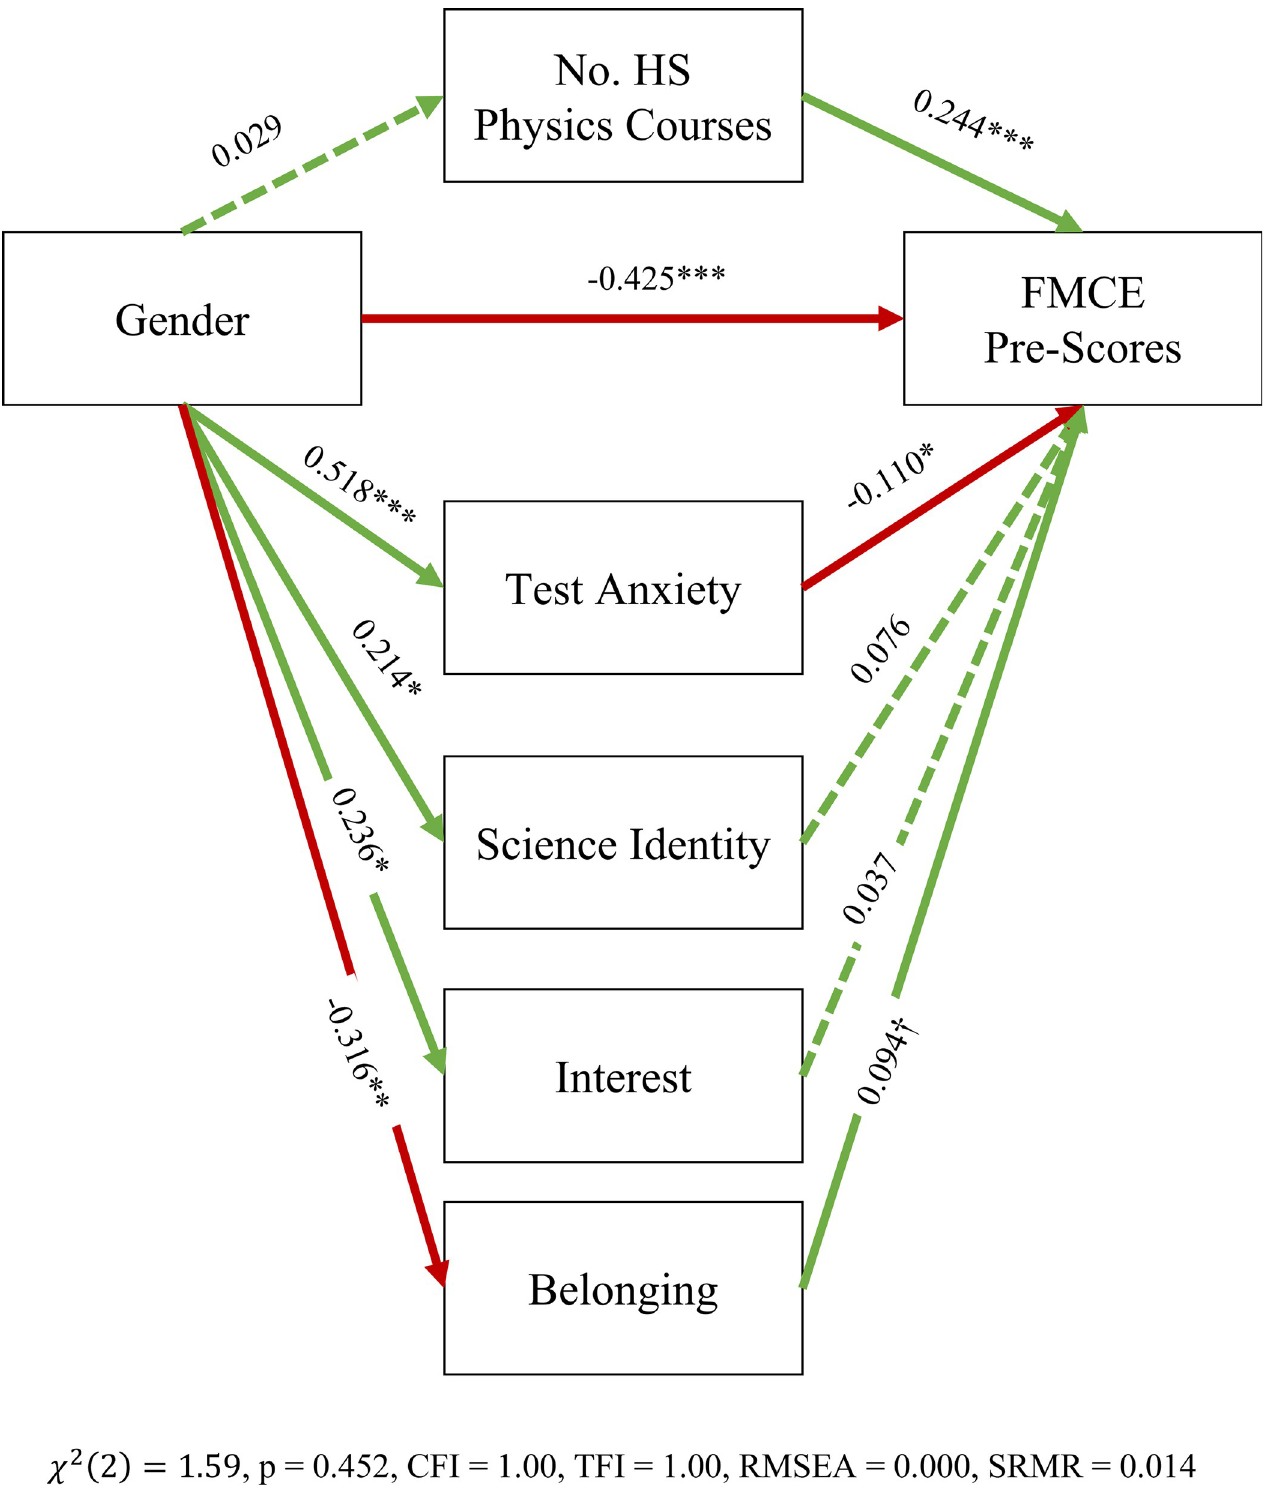
Fig 3. SEM model of the effects of gender on FMCE pre-scores as mediated by number of high school physics courses, test anxiety, science identity, and interest in physics. ��� p < 0.001, �� p < 0.01, � p < 0.05, † p < 0.10. Acceptable ranges: CFI > 0.95, TLI > 0.90, RMSEA < 0.08, SRMR < 0.05 and p > 0.05 for whole model. Dashed links are not significant at the p = 0.10 level. Red links indicate negative effects, while green links indicate positive effects.